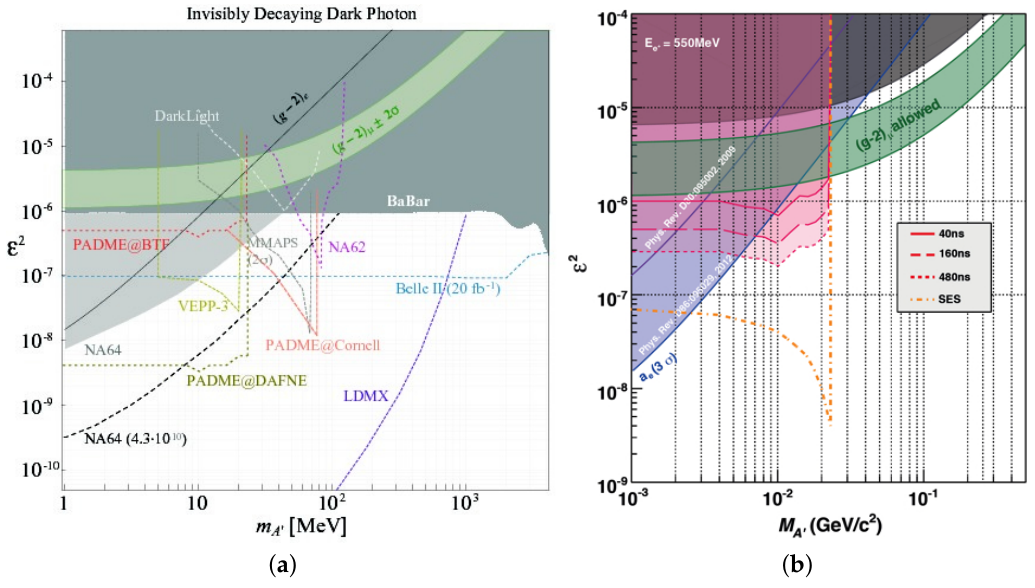
Figure 1. ( a ) Actual limits for invisible decay of DP; and ( b ) Padme sensitivity limits for 10 13 POTs and different bunch